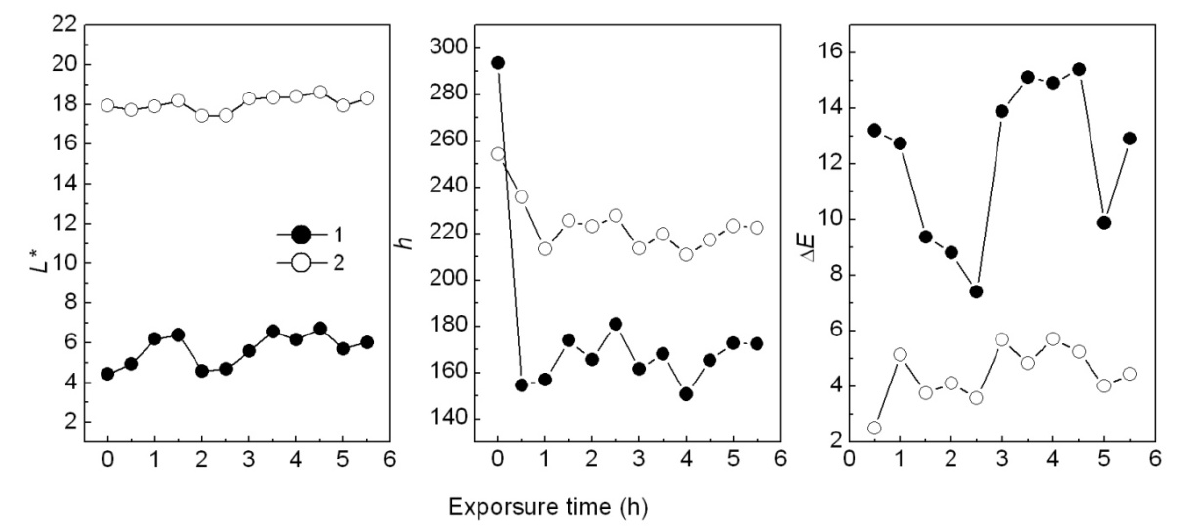
Figure 14. Effect of UV irradiation time on L* ( A ), h ( B ) and Δ E ( C ) of PP samples colored with the BaSO -MB hybrid ( 1 ) and the BaSO /MB mixture ( 2 ) at room 4 4